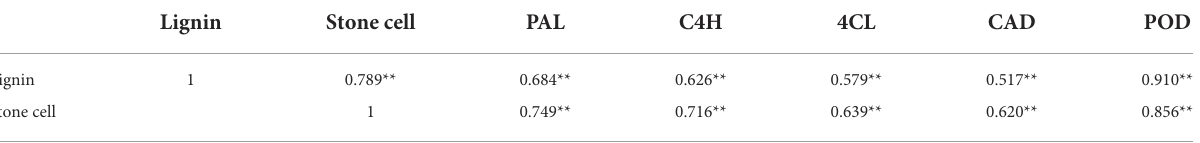
TABLE 1 Correlation analysis between stone cell, lignin content, and lignin-related enzyme activity. Lignin Stone cell